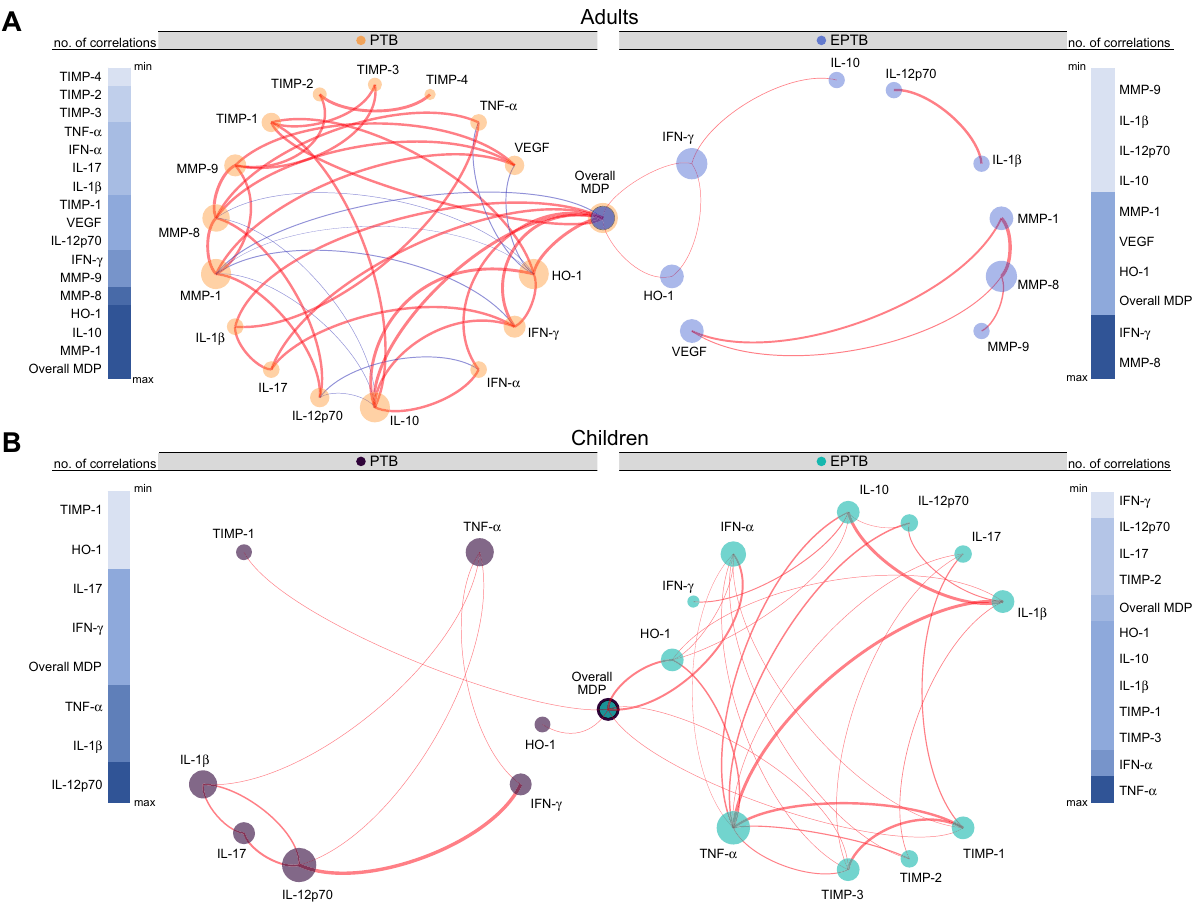
Figure 3. Network analysis of the MDP matrices in the study groups. ( A , B ) Spearman correlation matrices of the biomarker expression levels in each study group were built and Circos plots were used to illustrate the correlation networks. Each circle represents a different plasma parameter. The size of each circle is proportional to the number of significant correlations. P-values were adjusted for multiple measurements using Holm– Bonferroni’s method and the connecting lines represent statistically significant correlations (P < 0.003). Red connecting lines represent positive correlations while blue lines infer negative correlations. Color intensity is proportional to the strength of correlation (rho value). Node analysis was used to illustrate the number of significant correlations per marker. Markers were grouped according to the number of connections from minimum to maximum numbers